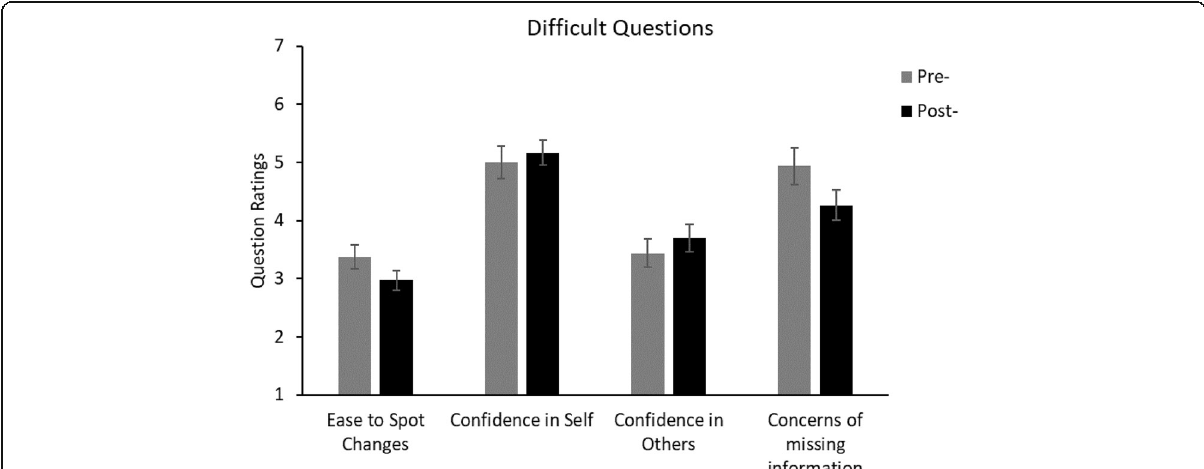
Fig. 6 Average ratings from the post-demonstration data of the difficult questions condition in Experiment 2. The pre-questionnaire data were taken from the replication condition for statistical comparison. For the “ ease to spot changes ” question, the rating scale ranged from 1 (very difficult) to 5 (very easy). For the other questions, the rating scales ranged from 1 (not at all confident/concerned) to 7 (totally confident/ concerned). Error bars represent the standard error. See Additional file 1 for the full